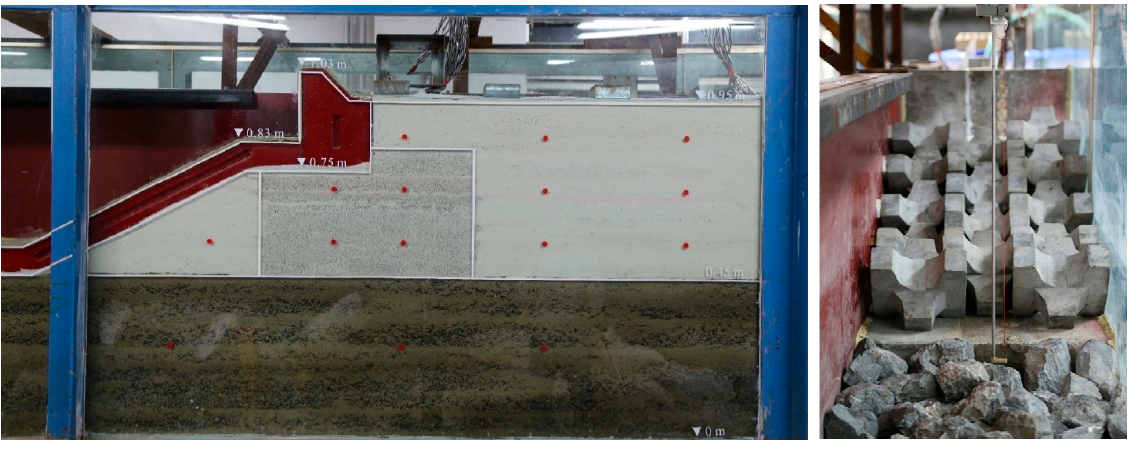
Figure 4. A real view of the completed physical model with accropodes and rubble in front of revetment breakwater.